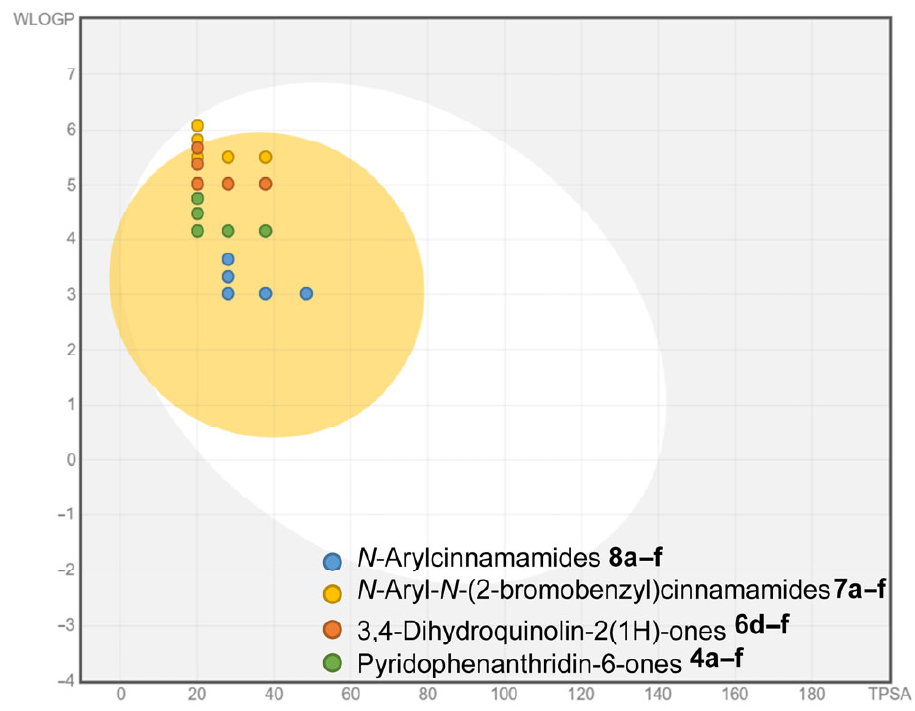
Figure 4. Overview of the BOILED-Egg construction for molecules 4 and 6 – 8 using the online SwissADME database.